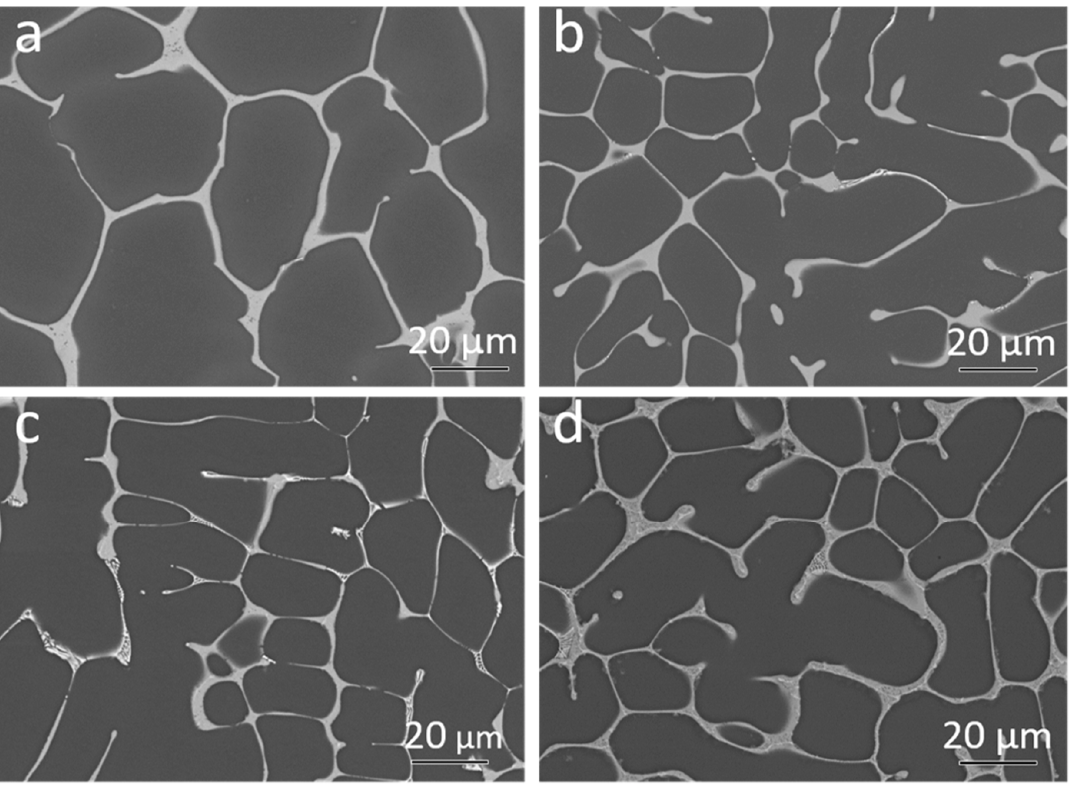
( c ) Figure 5. TEM observation of Mg-4Nd-5Zn in Selected Area Electron Diffraction ( a ) and ( c ) of two distinct intermetallic phases; ( b ) bright field mode. Figure 5b shows a bright-field TEM image of an area with two different intermetallic morphologies in the Mg-4Nd-5Zn alloy. Microbeam diffraction analysis performed on each